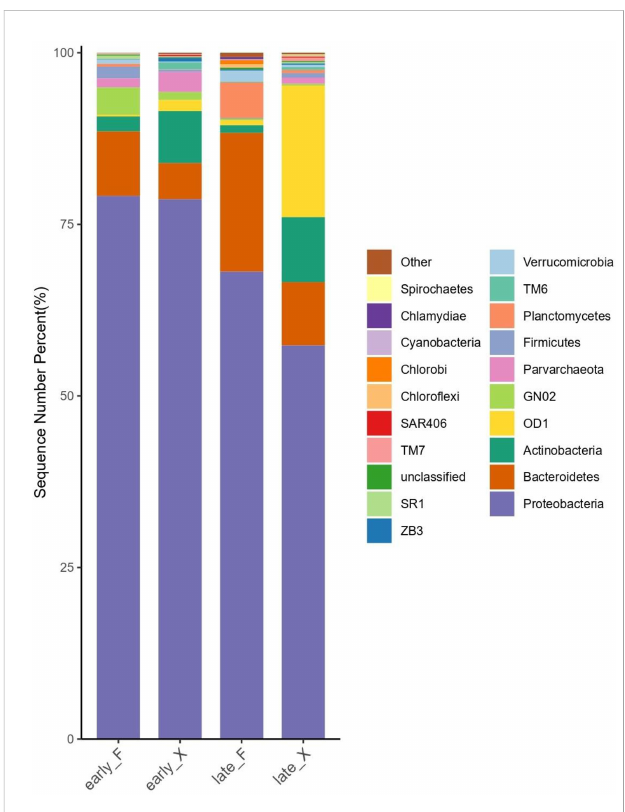
FIGURE 7 Column chart of relative distribution of microbes in each grouping at the phylum level (Top 20 Species in Relative